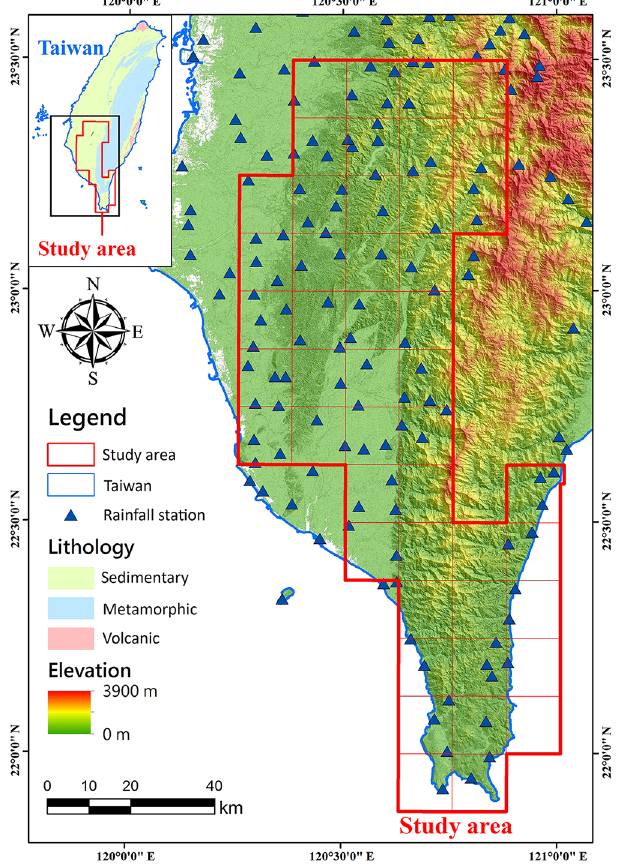
Figure 1. Geomorphological and geological settings of the study area. The elevation ranges from 3243m in the eastern mountain area to sea level in the western plains area. Lithological units are mainly metamorphic rocks in the Central Range and sedimentary rocks in the Western Foothills. Rainfall data of 423 stations in Taiwan (96 of which are located in the study area) were collected for the interpo- lation and analysis of the triggering rainfall of